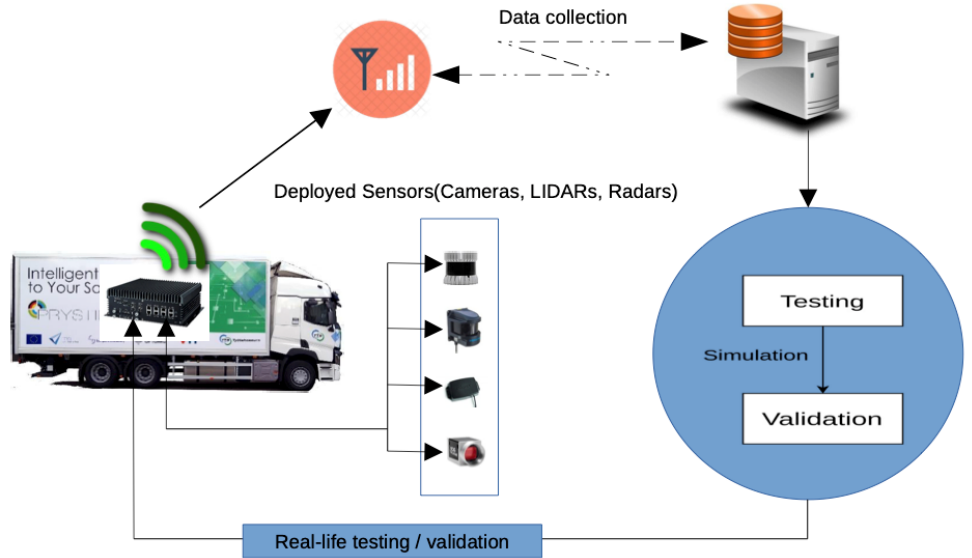
Figure 17. Demonstrator’s testing and validation